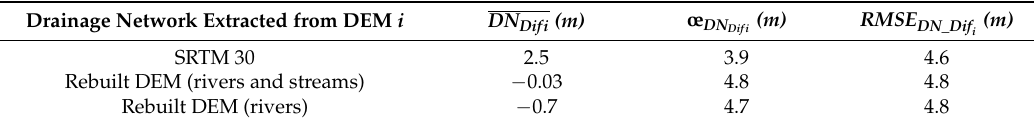
Table 4. Mean, standard deviation ( σ ), and root mean square error (RMSE) of the vertical distances between the points of each drainage under study (the original, the rebuilt with OSM rivers and streams and the rebuilt with OSM rivers) and the reference drainage network.